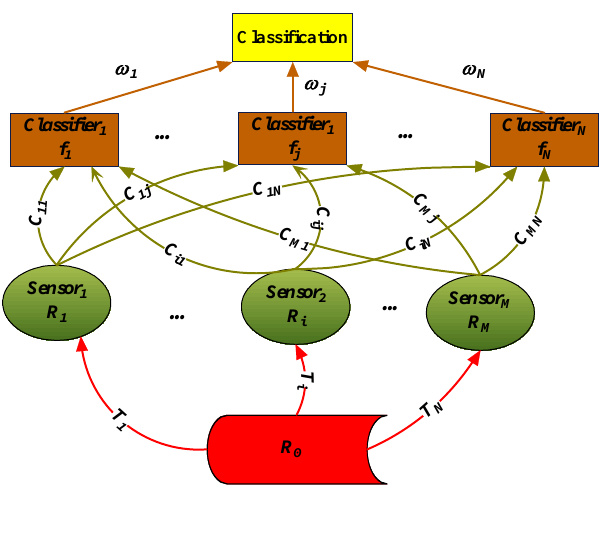
Figure 3. Framework of classifier ensemble in multi-sensor